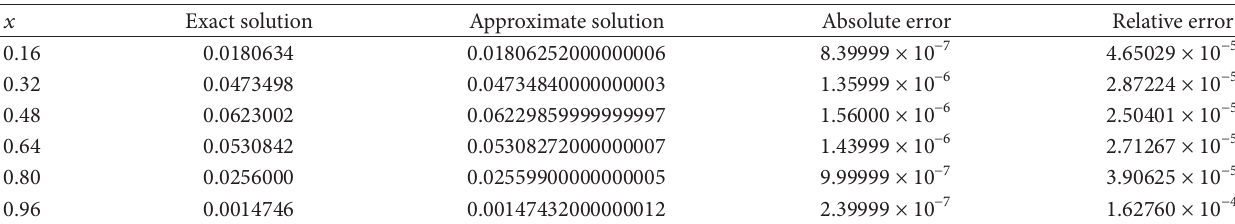
Table 4: Numerical results of 𝑢 1 (𝑥) for Example 2.